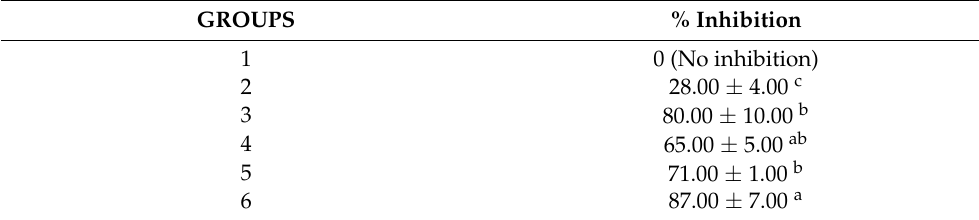
Table 4. Effect of M. oleifera extract on hemolytic activity of E. ocellatus venom. GROUPS %